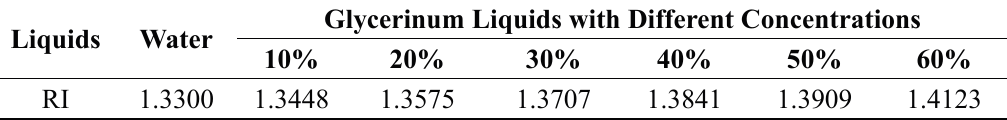
Table 1. Refractive index of glycerinum liquids with different